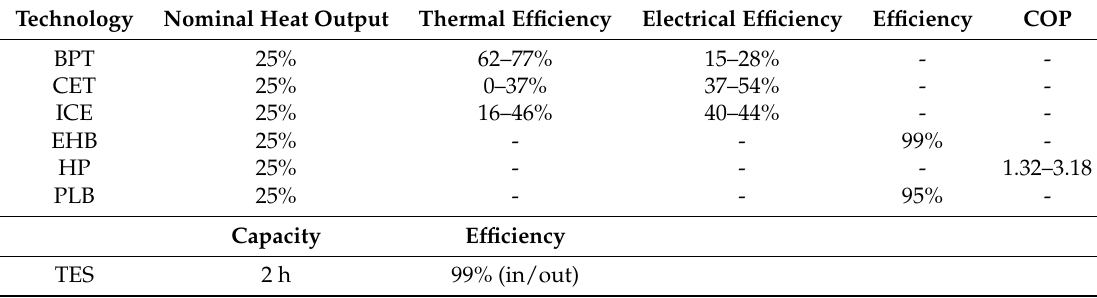
Table 2. Case study technology data (Heat output expressed as share of maximum heat load; capacity given in h of maximum annual heat load; BPT—back pressure turbine, CET—combined cycle extraction turbine, ICE—internal combustion turbine, COP—coefficient of